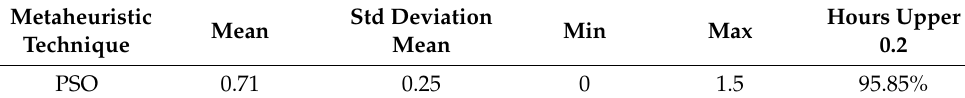
Figure 16. FRC distribution in Case 2 by scheduling hourly dosage pattern obtained in Figure 15. Table 5. Characteristics of critical nodes in Case 2. Table 6. Statistical values of FRC (mg/L) from the last 24 h of simulation in all nodes.